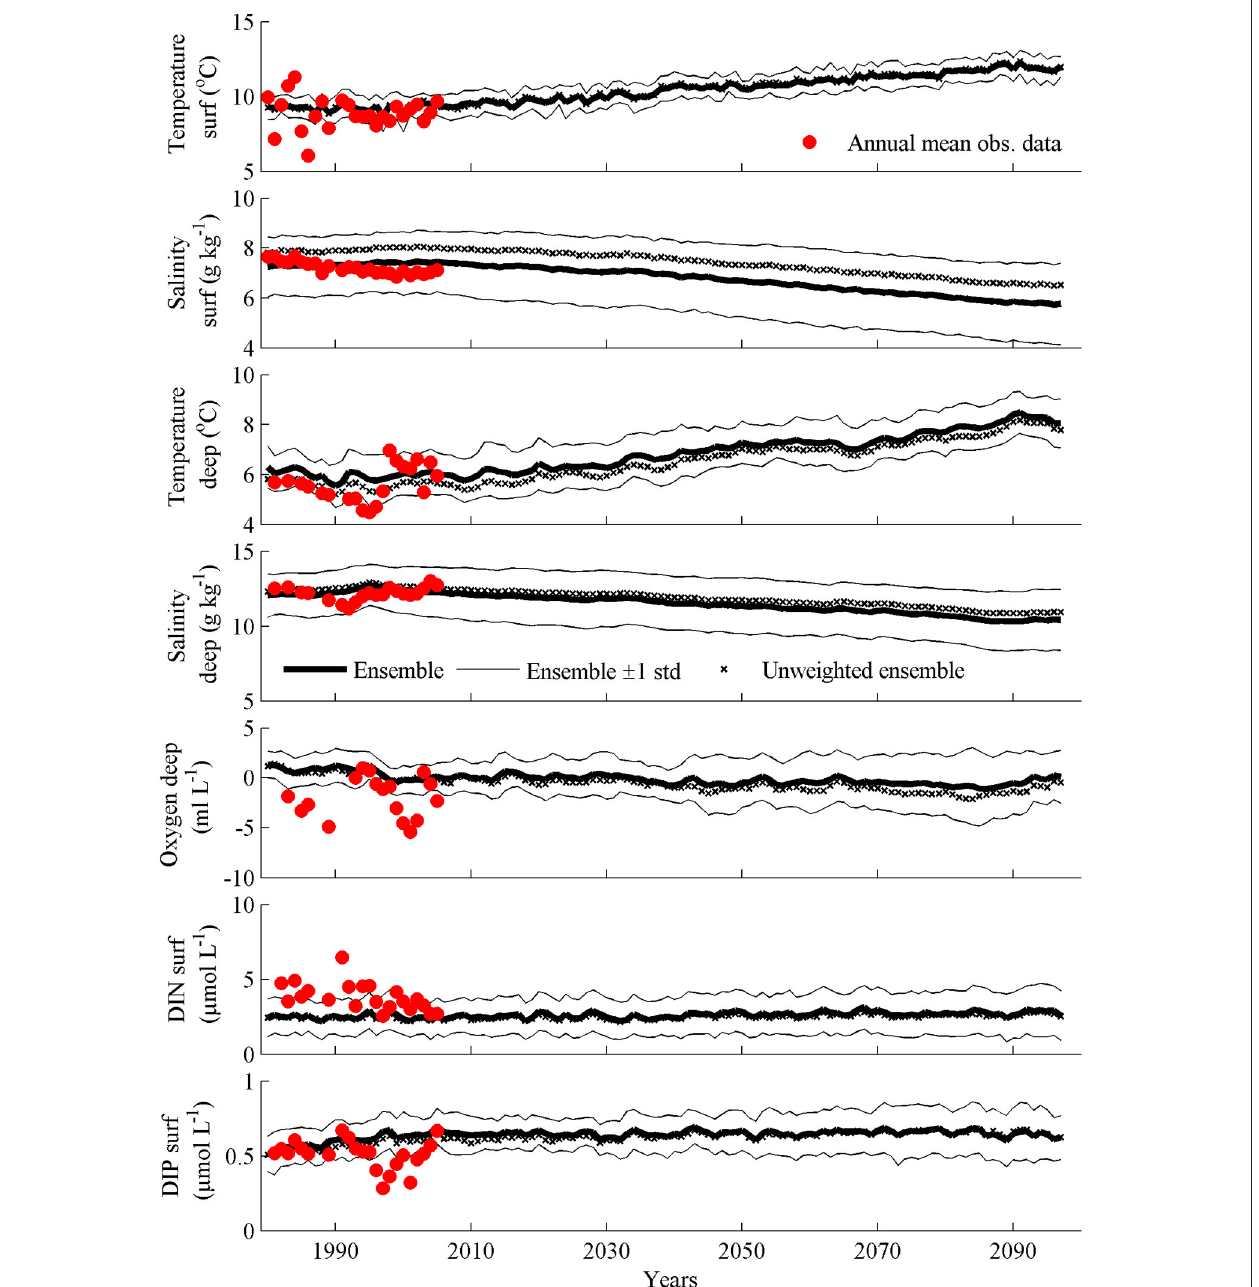
FIGURE 4 | Simulated (black lines) and observed (red circles) annual mean water temperatures (in ◦ C) and salinities (in g kg − 1 ) at Gotland Deep in the surface (surf) and deep layer (deep), annual mean oxygen concentrations (in mL O 2 L − 1 ) in the deep layer, and winter (December-February) mean dissolved inorganic nitrogen (in mmol N m − 3 ) and phosphorus (in mmol P m − 3 ) concentrations in the surface layer. Data have been extracted from the models’ top grid cell for the surface layer (surf) and for the grid cell closest to 200m for the deep layer (deep). Shown are the weighted and unweighted ensemble means and plus/minus one standard deviations of all simulations performed with Model A to H for the period 1980–2097. In all scenario simulations, the REF nutrient load scenario is